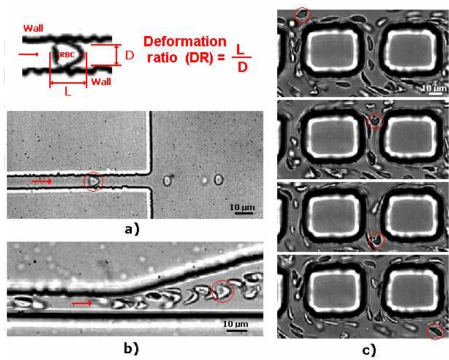
Figure 9. RBCs flowing through ( a ) rectangular PDMS microcapillary ( b ) divergent region upstream of a rectangular PDMS microcapillary; and ( c ) micropillars, adapted from [31].